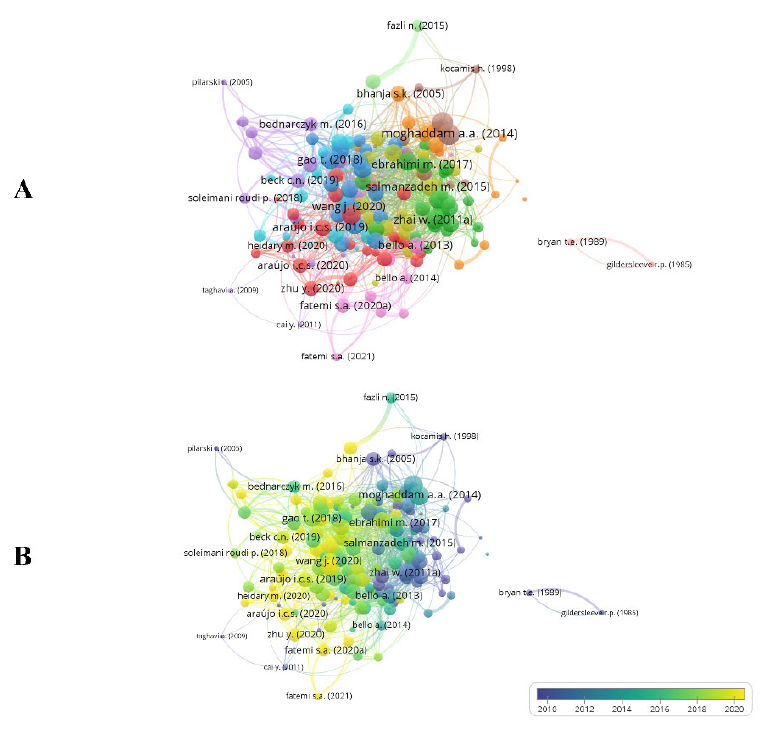
Figure 4. Bibliographic coupling of documents.